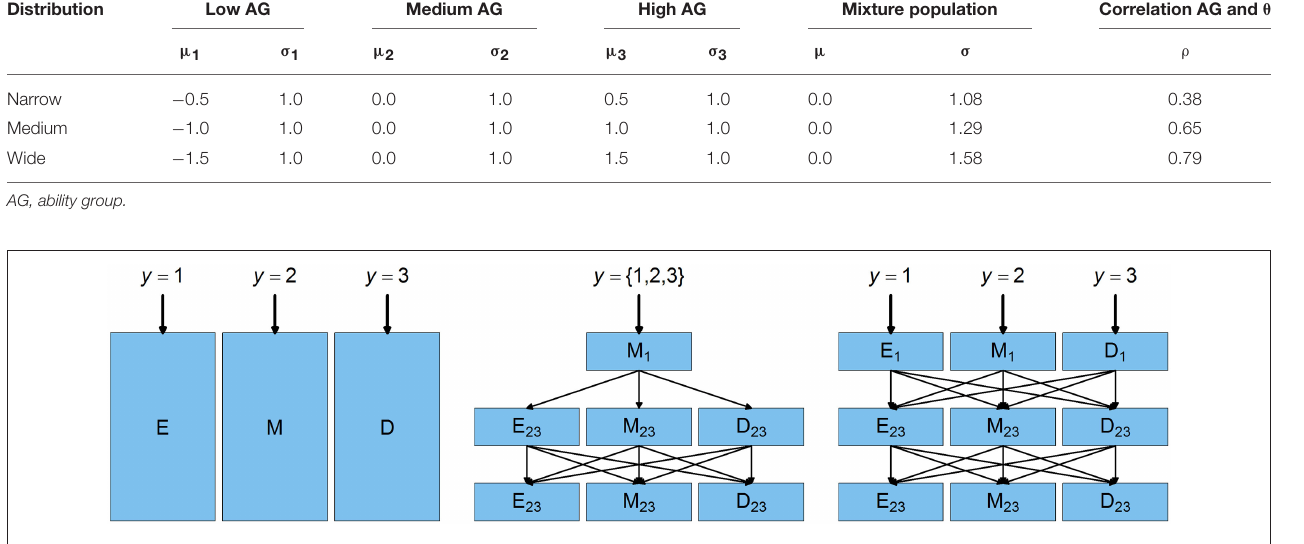
FIGURE 1 | Illustration of the targeted, MST, and TMST designs. y , ability-related background variable (e.g., grades in school); E, easy module, M, moderate module, D, difficult module; E